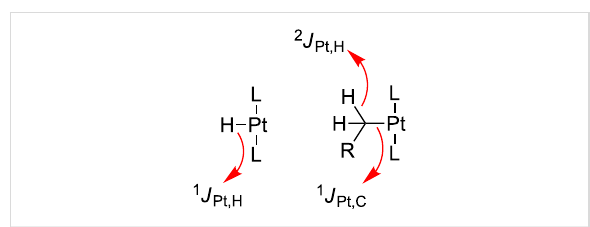
through the observation (in some cases) of NMR signals for the C–H bonds involved in agostic interactions, but also by the magnitude of the coupling constant of some of the ligands around the metal center with the NMR active 195 Pt nuclei (33.7% natural abundance). This is actually not the case with Table 2: NMR coupling constants of selected three-coordinate Pt(II) 31 P NMR, for which the J Pt,P values seem to be virtually insen- sitive to the nature of the complex. As an example, in the boryl derivatives reported by Braunschweig et al. [21] the J Pt,P coupling constant is almost the same both in the starting ma- terial, [Pt(BR 2 )Br(PCy 3 ) 2 ], and in the three-coordinate Pt(II) species, [Pt(BR 2 )(PCy 3 ) 2 ][BAr F ] T2 . On the other hand, the coupling constants of the proton and carbon atoms of alkyl and hydride ligands with 195 Pt are very sensitive to the presence of coordinating ligands trans to them (Figure 14).